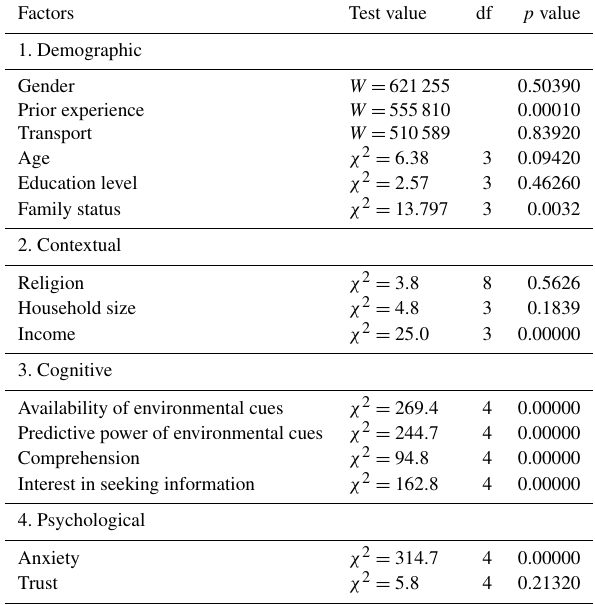
Table 2. Results of Wilcoxon and Kruskal–Wallis tests testing the control of different variables on risk perception. W indicates Wilcoxon’s rank sum test and χ 2 the value of Kruskal–Wallis’s chi- squared